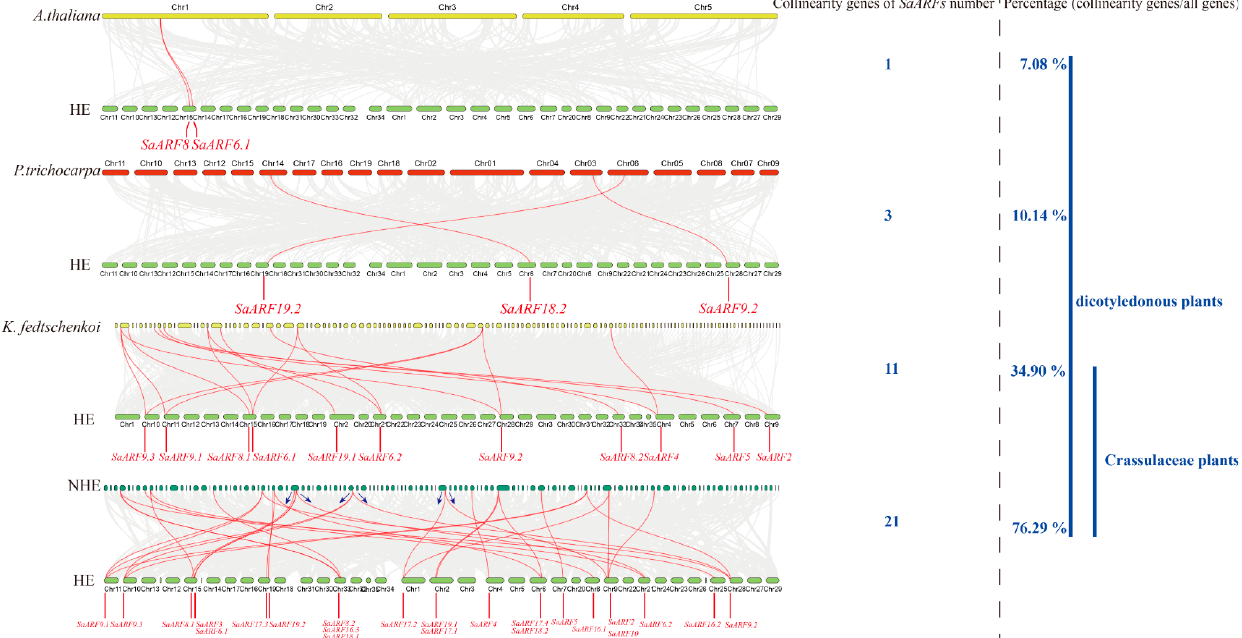
Figure 3. Collinearity relationships between HE and other species. The grey lines indicated colline- arity relationships of other genes (except SaARFs ). The red lines indicated the collinearity relationships of SaARFs . The blue arrows indicated that one ARF gene of NHE corresponded to two or three ARF genes of HE.